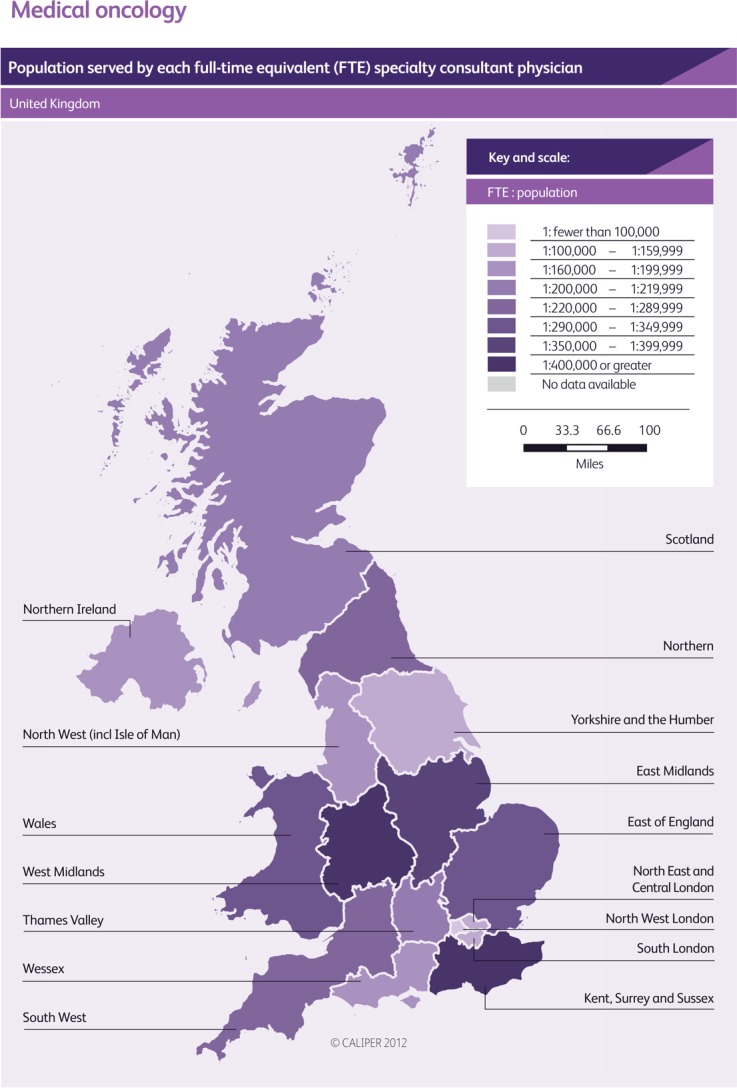
Data provided by the Royal College of Physicians shows an uneven distribution of medical oncologists across the United Kingdom. Reproduced with permission. (Federation of the Royal Colleges of Physicians of the UK. Census of consultant physicians and higher specialty trainees in the UK: specialty reports, 2013–14. London: Royal College of Physicians, 2015: 155 and 157.)